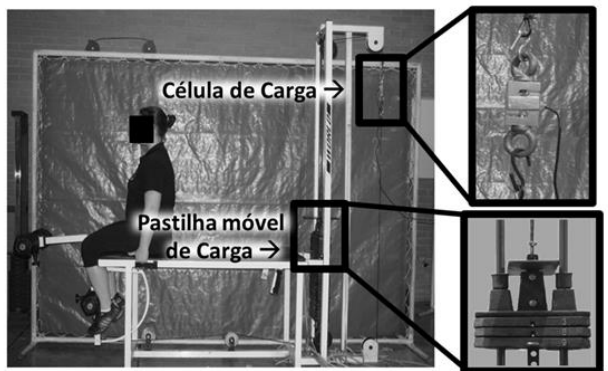
Figura 1. Máquina de musculação Mesa